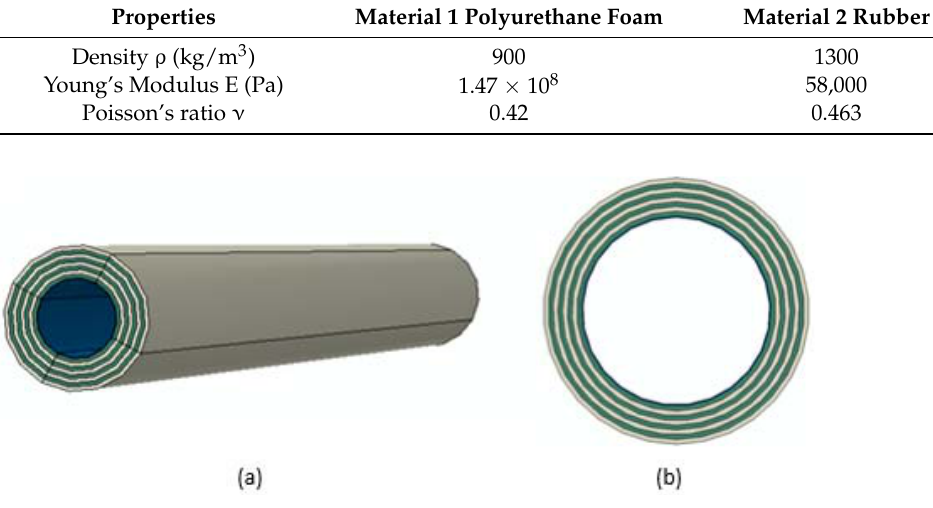
Figure 4. A 3D representation ( a ) and cross section ( b ) of the meta-material layout, consisting of eight layers (of 5.00 cm thickness each). The green layers refer to the polyurethane foam, the grey to rubber, and the blue layer to the pipe (of 1.50 cm thickness).